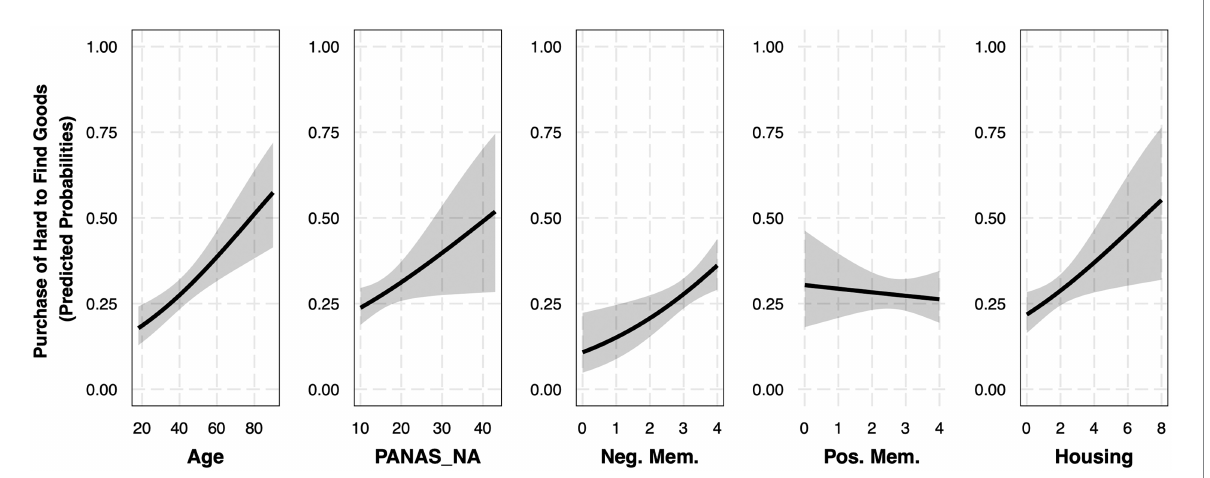
FIGURE 3 Purchase of extra hard-to-find goods is significantly related to negative memory (Controlling for housing). Each plot represents the effect of a given independent variable controlling for the other independent variables in Goods Model 2.3 (controlling for housing). Independent variables that produced significant effects have black borders. All variables were mean-centered in this model with the exception of housing, but for visualization purposes all variables are plotted with uncentered values. N =